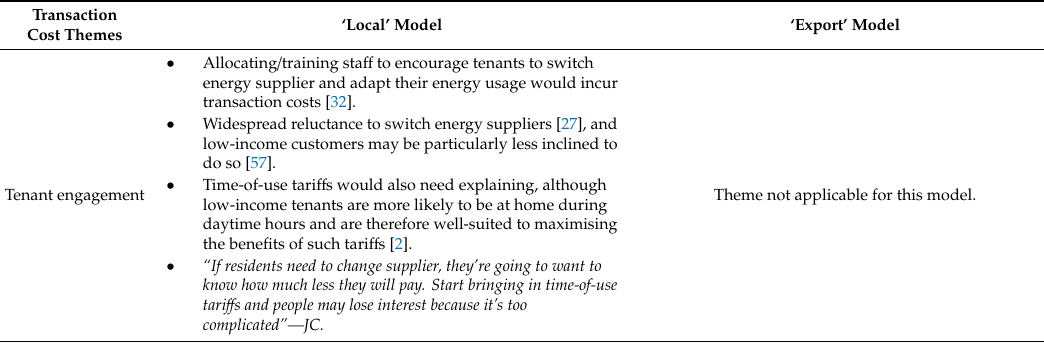
Table 4. Transaction cost themes for both models from interview transcript